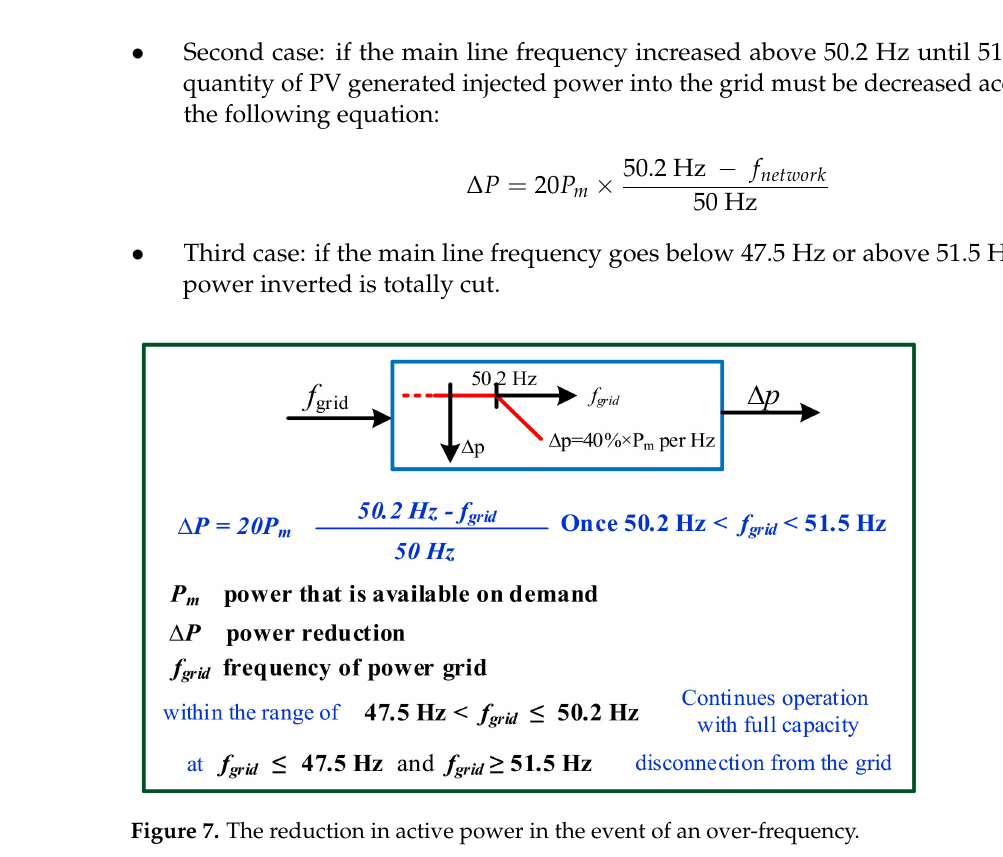
Figure 7. The reduction in active power in the event of an